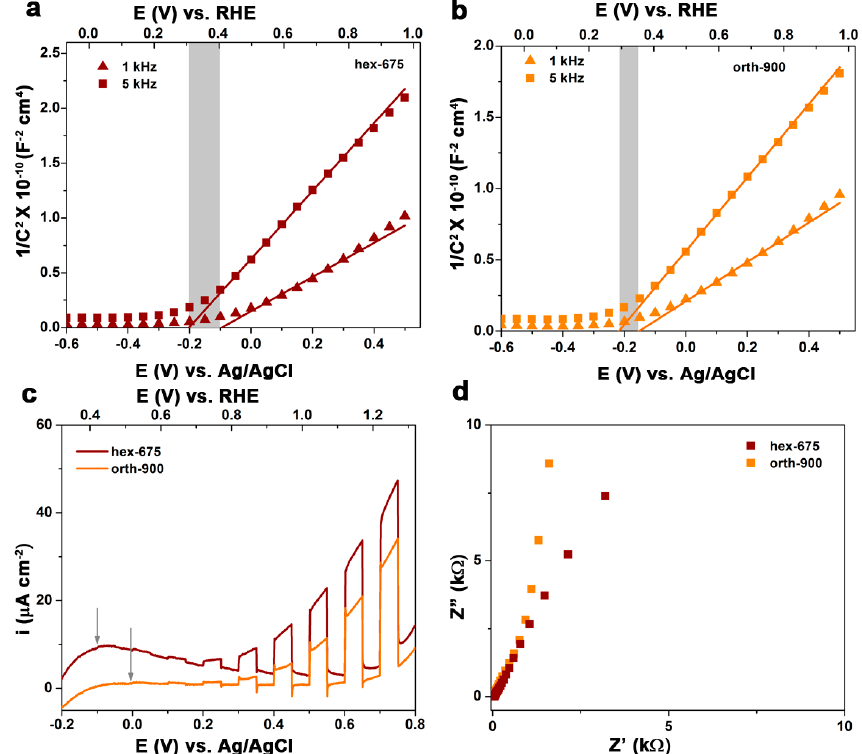
Figure 5. Mott ‐ Schottky plots at 1 kHz and 5 kHz of ( a ) hex ‐ 675, ( b ) orth ‐ 900, ( c ) chopped light photocurrent measurements in 0.1 M Na 2 SO 4 /0.1 M Na 2 SO 3 solution (pH = 5.6) under white light emitting diode (LED) illumination, and ( d ) Nyquist plot of hex ‐ 675 and orth ‐ 900 in 0.1 M Na 2 SO 4 (pH = 5.6) at 0.1 V vs. Ag/AgCl.